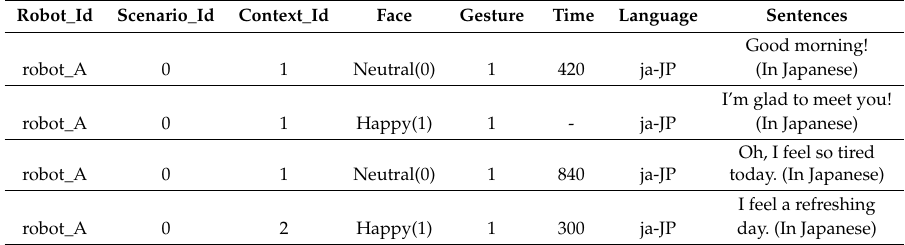
Table 6. Interaction design template for robot partner